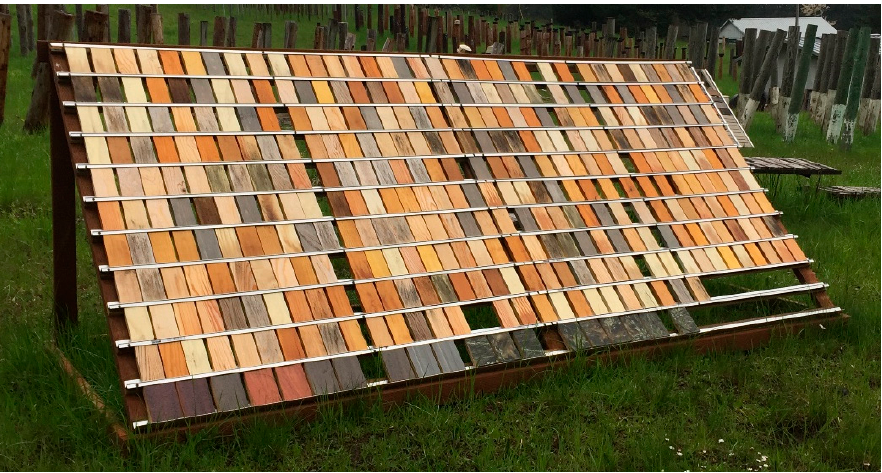
Figure 1. Coated samples exposed to natural weathering at a 45° angle on a test fence near Corvallis, OR.